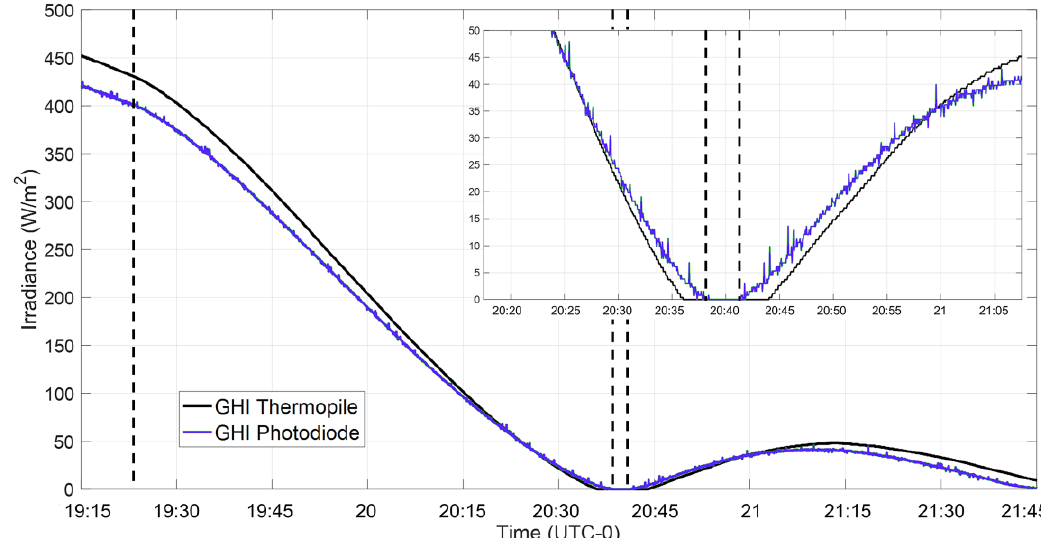
Figure 12. Differences in measurements of the eclipse between thermopile and photodiode sensors. Vertical dashed lines mark contact points C1 through C3 according to astronomical algorithm.